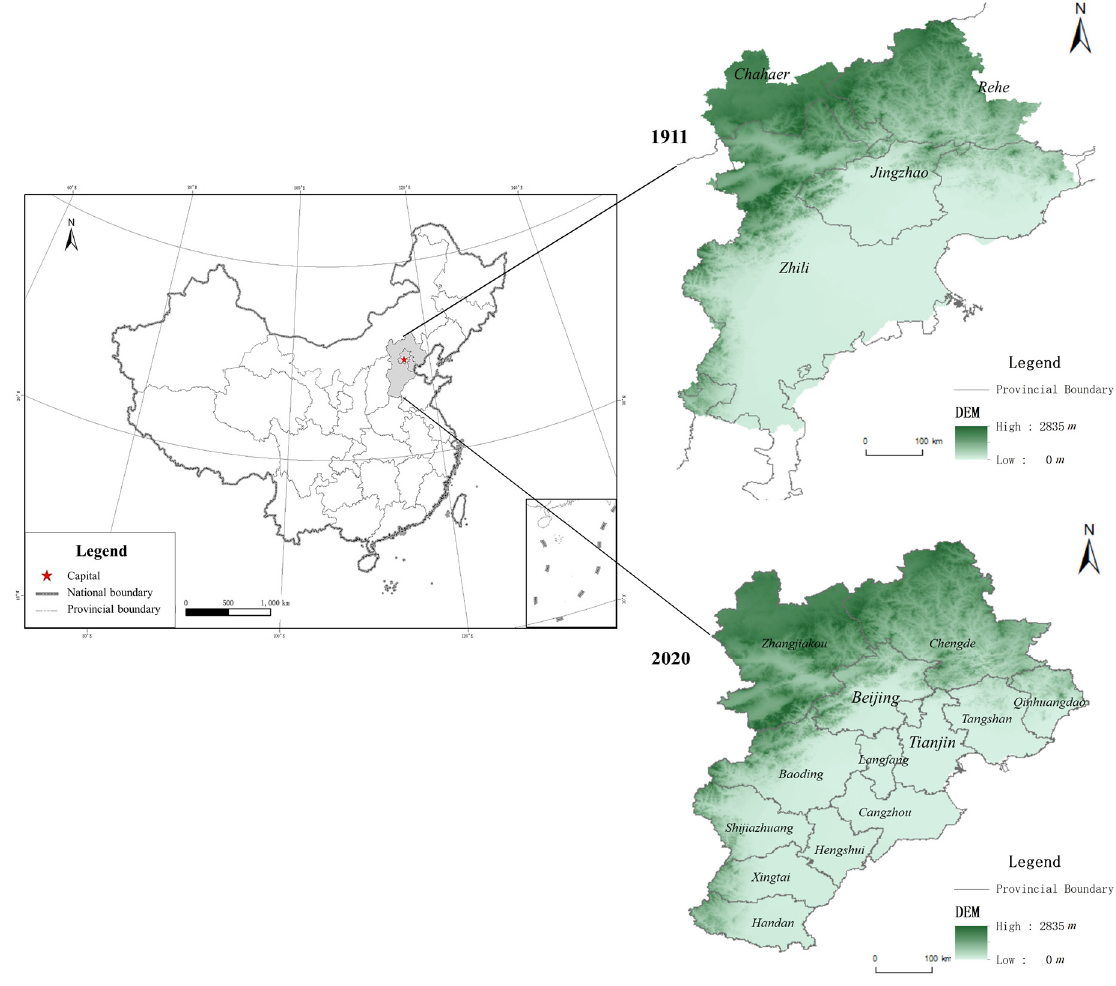
Figure 2. The spatial location of the Beijing-Tianjin-Hebei (BTH) region (1911 in late Qing Dynasty and 2020 for